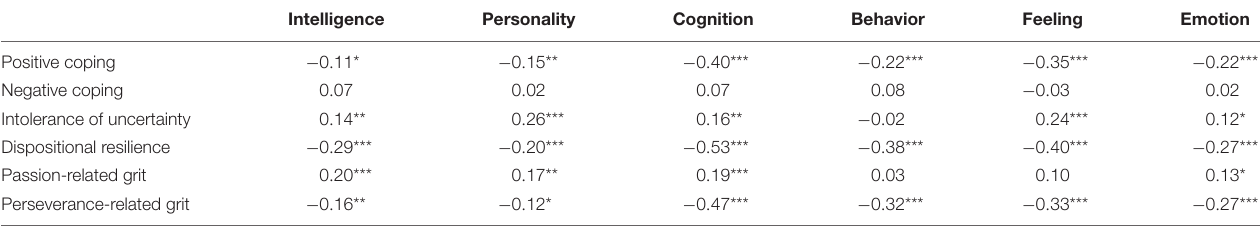
TABLE 7 | Domain-level correlation with relevant psychological attributes in Study 3.